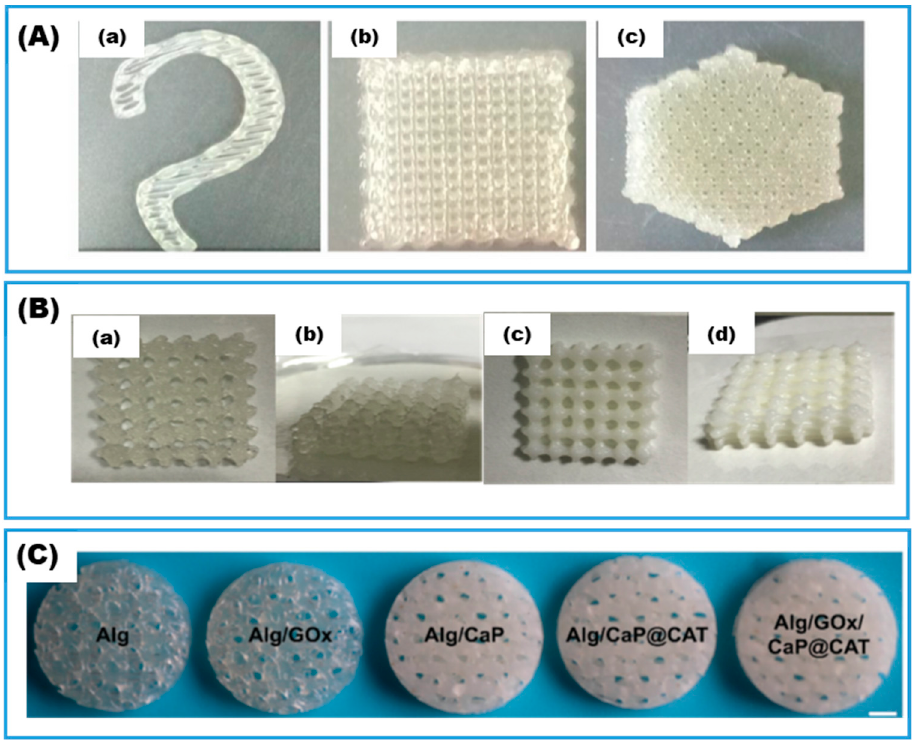
Figure 6. Alginate-based hydrogels. ( A ) The 3D printed xylanase entrapped in sodium alginate hydrogel: ( a ) hook-shaped; ( b ) quadrilateral lattice; ( c ) hexagonal lattice (adapted with permission from Ref. [70]). ( B ) Interpenetrating polymer network (IPN) and hybrid interpenetrating polymer network (HIPN) hydrogel: ( a , b ) sodium alginate/polyacrylamide (SA/PAm) IPN; ( c , d ) sodium alginate/polyacrylamide/hydroxyapatite (SA/PAm/HA) HIPN (reproduced with permission from Ref. [23]). ( C ) Appearance of 3D printed alginate-based hydrogel (Alg) with or without immobilized glucose oxidase (GOx), calcium phosphate micro-sheet (CaP), or catalase-induced biomineralized calcium phosphate nanosheet (CaP@CAT) (adapted with permission from Ref.